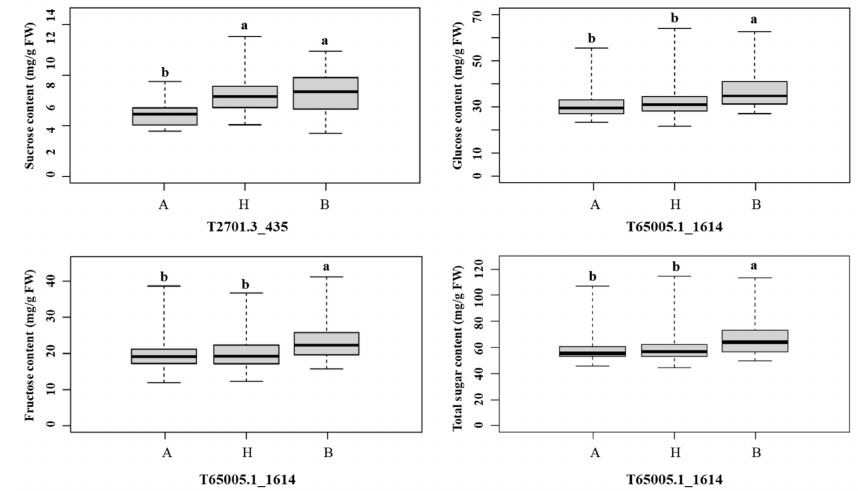
Figure 5. Phenotypic distribution of sugar content measured in the ‘16P118 × Sweet Green’ mapping population based on SNPs closet to the QTL peaks. Bars on graphs indicate standard error and different small letters (a and b) refer to significant differences ( p < 0.05) according to Duncan multiple range test. A, genotype of female parent (16P118); B, genotype of male parent (Sweet Green); H, genotype of